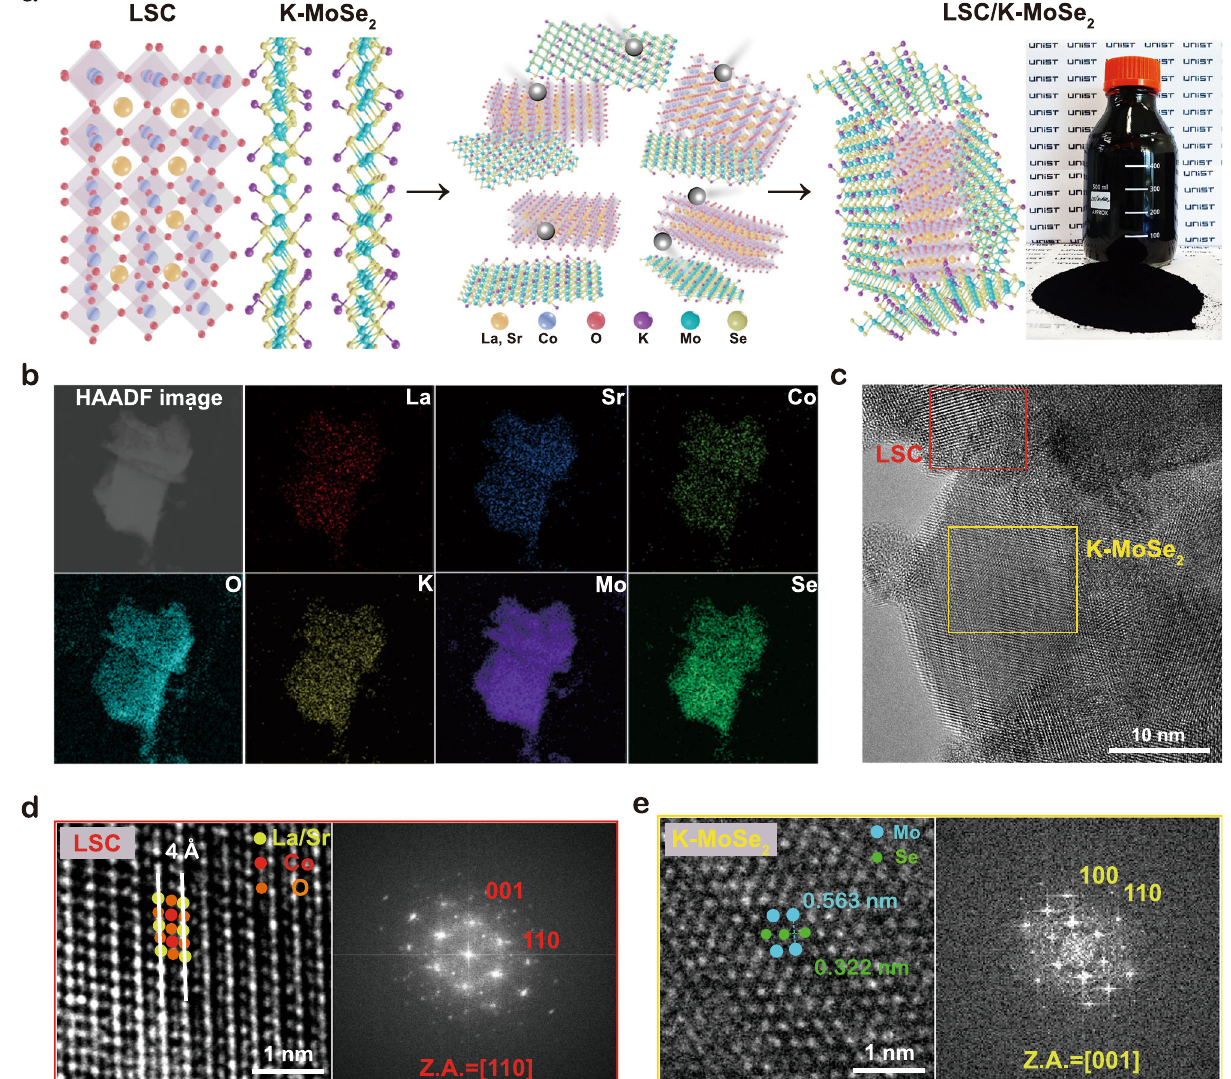
Fig. 1 Elemental and morphological characterizations of LSC/K-MoSe 2 heterostructure. a Schematic illustrating the synthesis process of LSC/K-MoSe 2 . Digital image demonstrates the large-scale synthesis capability of the proposed method. b HAADF-STEM image and corresponding EDS elemental mapping of La (red), Sr (blue), Co (yellow green), O (cyan), K (yellow), Mo (purple), and Se (green). c HR-TEM image of LSC/K-MoSe 2 , showing typical morphological characteristics of the heterostructure comprising the LSC (red square) and K-MoSe 2 (yellow square) regions. d Representative HR-TEM image of LSC and corresponding FFT image, indicating the lattice structure of La/Sr, Co, and O with high crystallinity. e Representative HR-TEM image of K-MoSe 2 and corresponding FFT image, exhibiting the highly crystalline lattice structure of 1T-phase MoSe 2 comprising Mo and